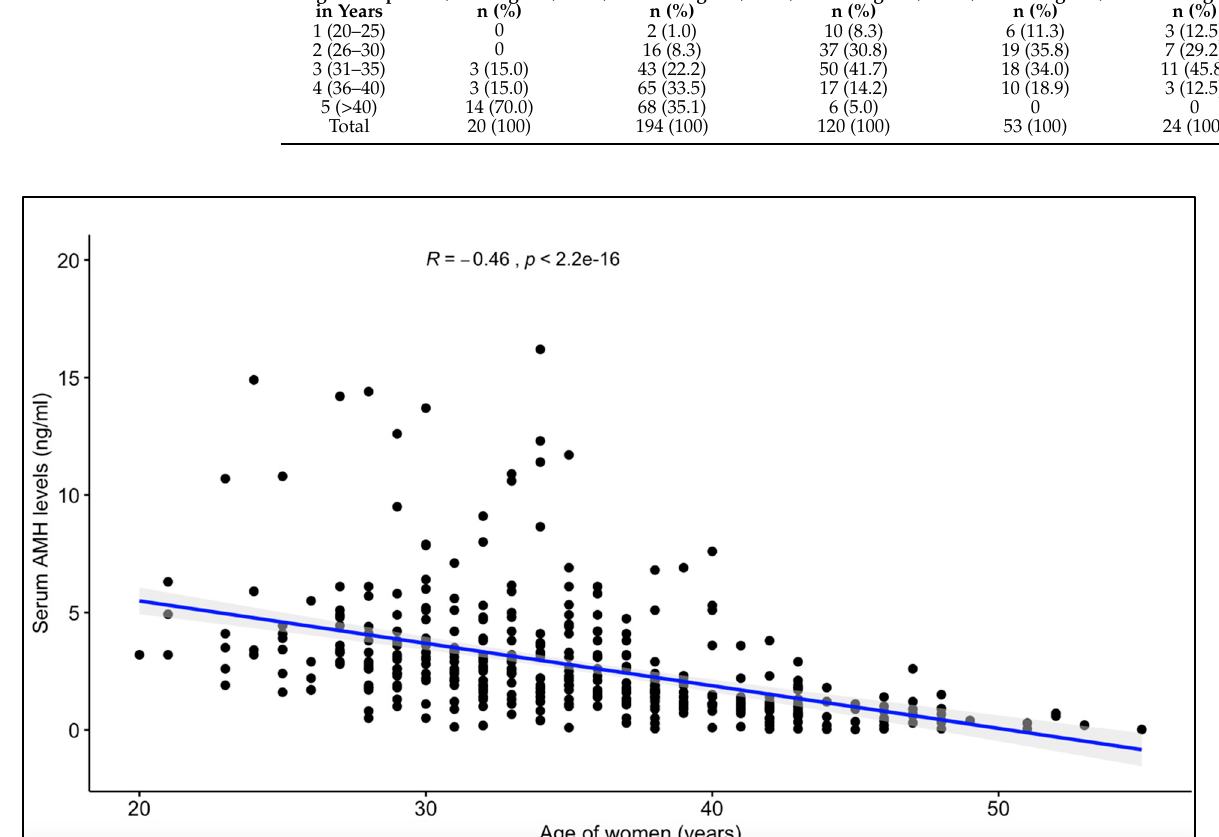
Figure 2. Correlation between women’s age and their serum AMH levels.